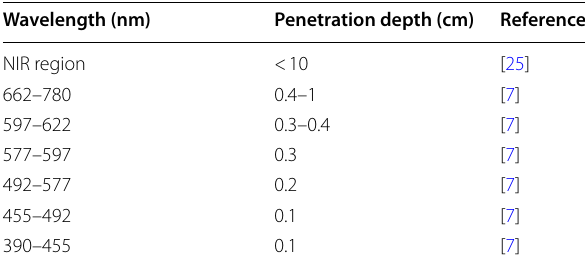
Table 1 Penetration depth of different wavelengths of